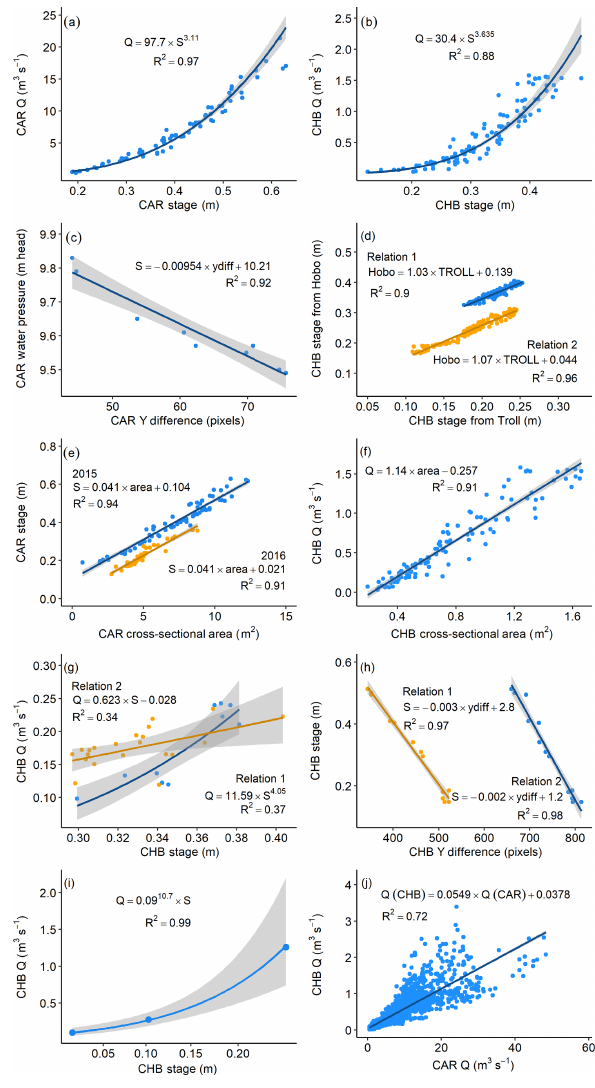
Figure 7. Regression relations and associated confidence bands used to create continuous discharge ( Q ) time series throughout the 2015–2018 open-channel seasons in Carnivore (CAR) and Cham- berlin (CHB) creeks. (a) Discharge – stage ( S ) relation for CAR (2015); (b) discharge – stage relation for CHB (2015); (c) water- pressure (from TROLL) – vertical difference ( y diff; shown on photographs) relation for CAR (2015); (d) relations of stage cal- culated from Hobo U20 water pressure against stage calculated from TROLL 9500 water pressure for CHB (both 2015); (e) stage – cross-sectional area linear relation for CAR (2015 and 2016); (f) discharge – cross-sectional area linear relation for CHB (2015); (g) discharge – stage (from Hobo) power relation for CHB (2016); (h) stage – vertical difference ( y diff; shown on photographs) lin- ear relations for CHB (both 2016); (i) discharge – stage exponen- tial relation for CHB (2016); and (j) relation of discharge in CHB against discharge in CAR with a 2h lag (2015 and 2016). Refer to Thurston (2017) for additional